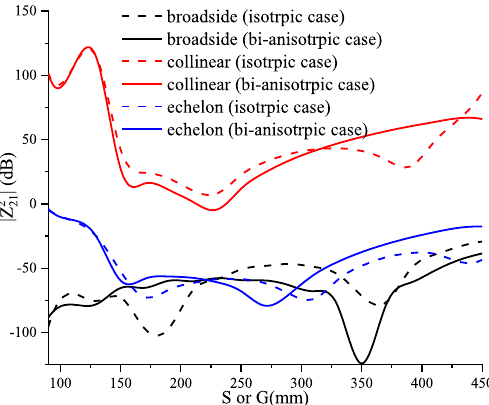
Figure 26. Mutual coupling for different configurations with combined chiral and Tellegen elements.